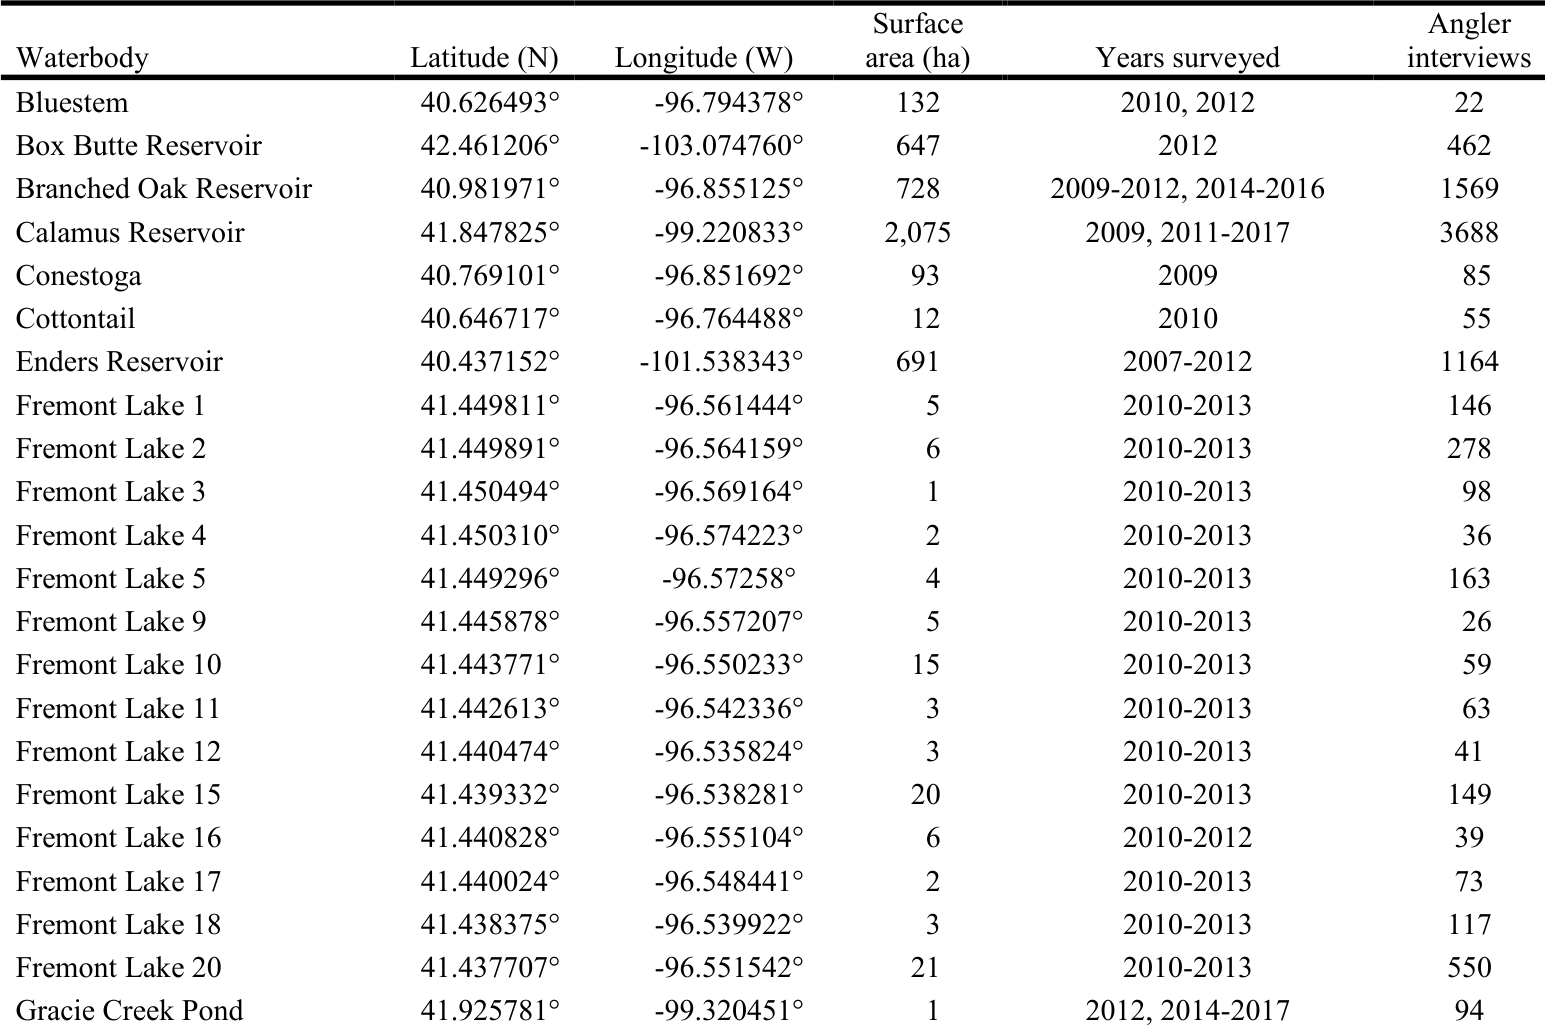
Table A1.1. Water bodies surveyed and physical characteristics, years surveyed, and the number of angler-parties